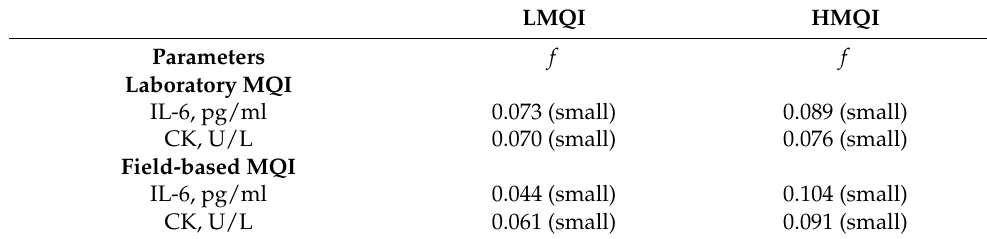
Table 3. Values of effect size for main effect of time.